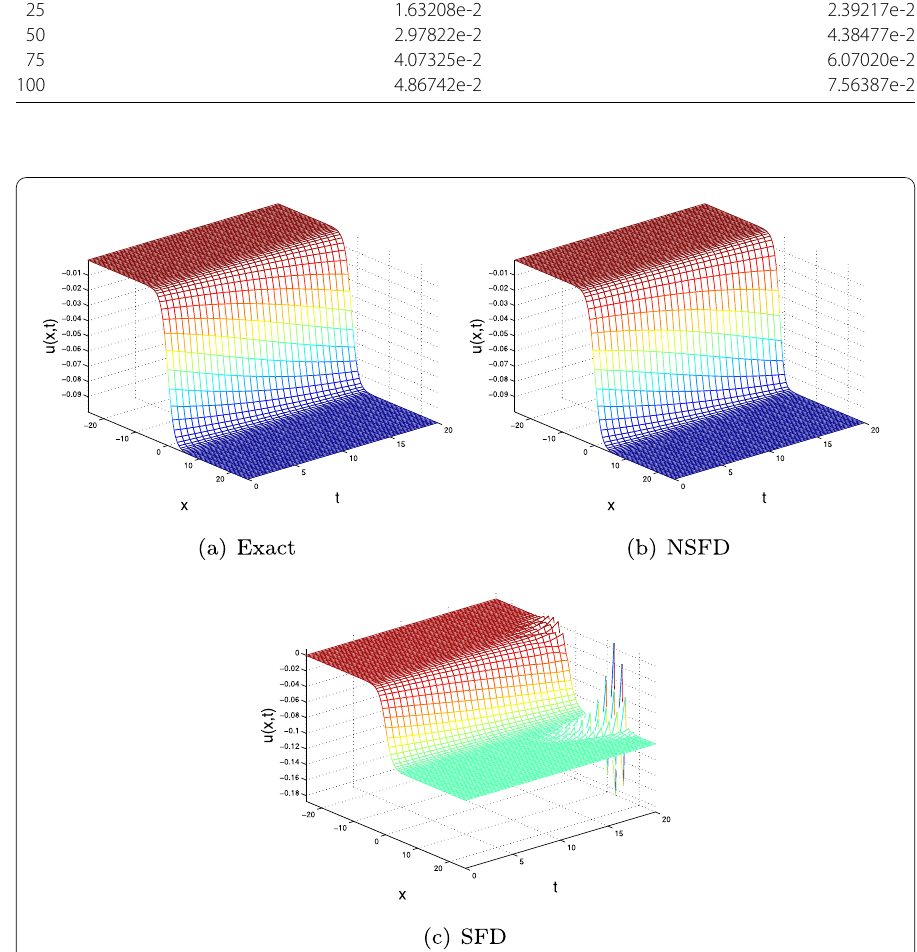
Figure 1 ( a ) Exact, ( b ) NSFD, ( c ) SFD: Surface of the wave for h = 0.5, (cid:3) t =